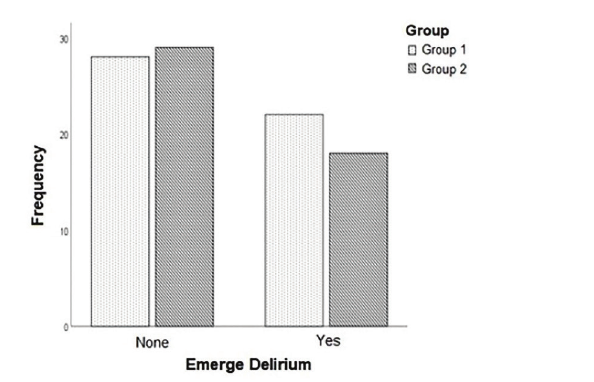
Figure 2 - Comparison of the patient groups by the presence of emergence delirium The mean serum 1.25(OH) D3 level was higher, albeit 2 insignificantly, in group 1 than in group 2[34.4 (min.15.1, max. 46.6) pg/mL vs. 25.9 (min.13.1, max.28.2) pg/mL, p= 0.177] (Figure 1). The blood samples for serum vitamin D level measurements were taken in winter in 66% (64/97) of the children; however, no significant difference was found between the groups in terms of the season of taking the blood sample